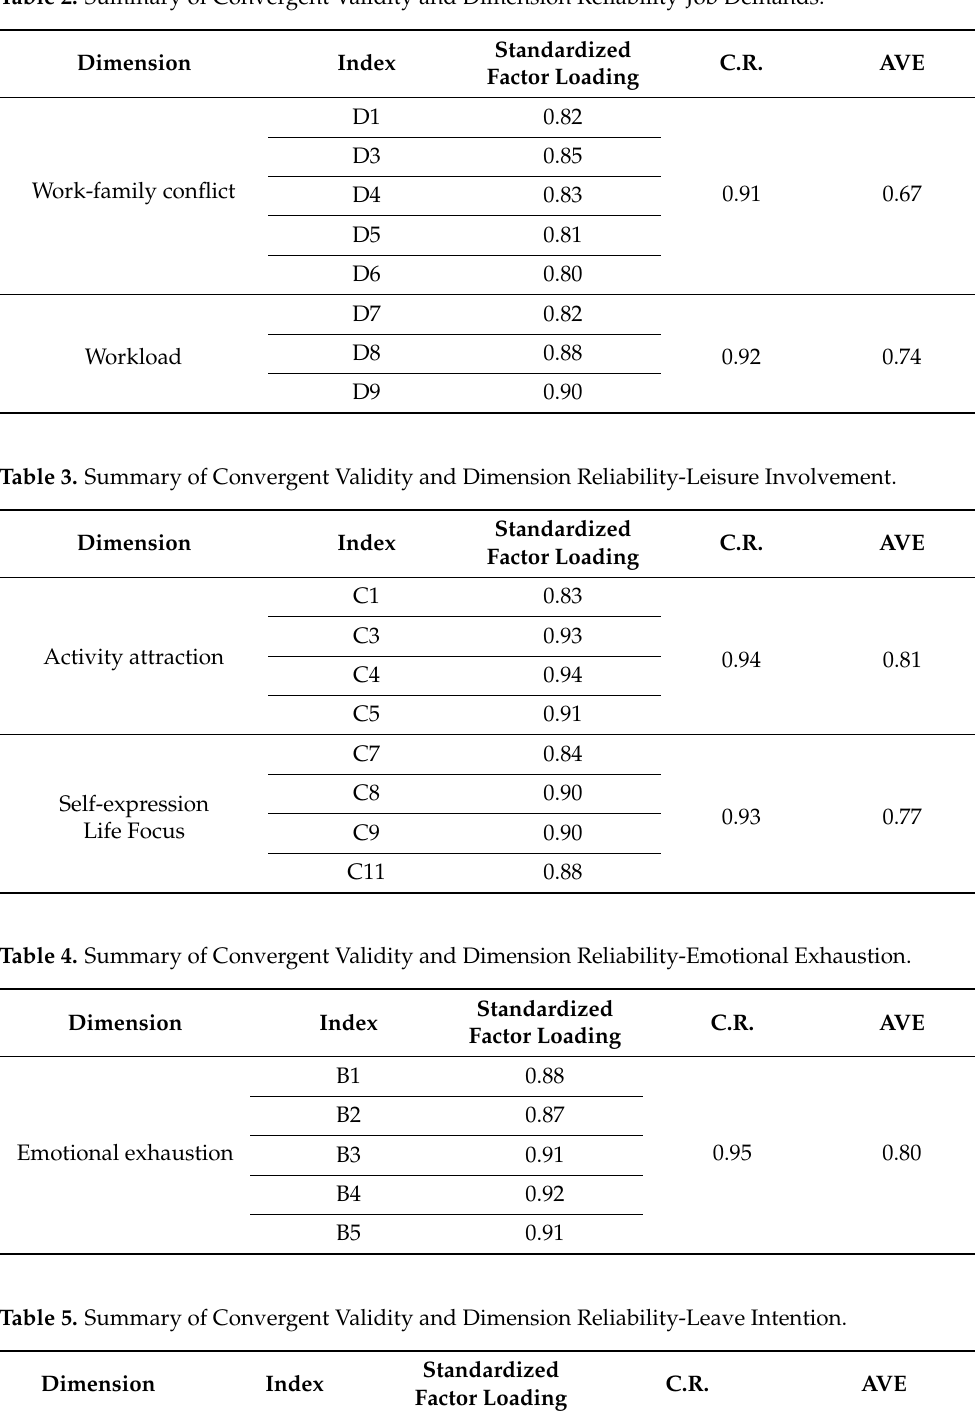
Table 2. Summary of Convergent Validity and Dimension Reliability-Job Demands.